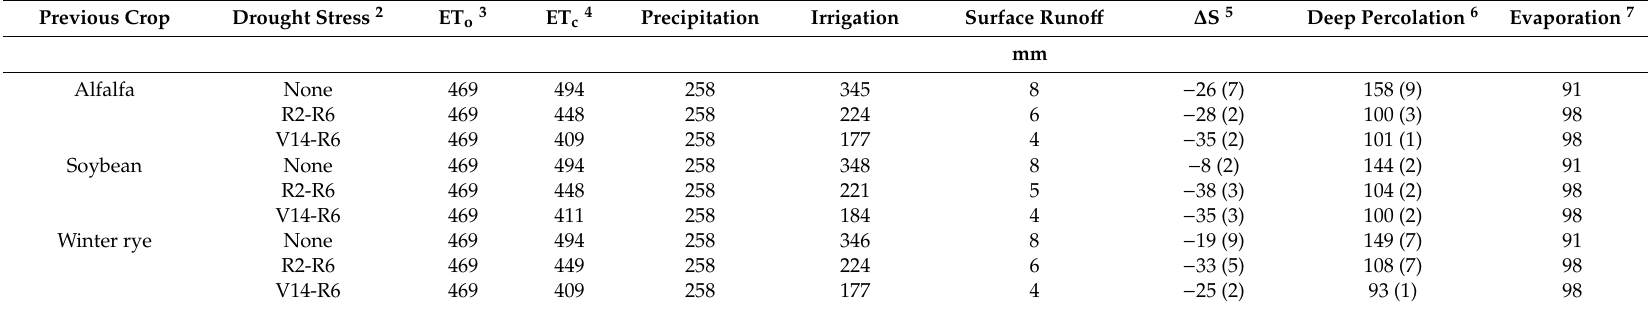
Table 2. Means and standard errors of cumulative water balance components from maize emergence to maize physiological maturity (R6) for plots with the optimal nitrogen rate 1